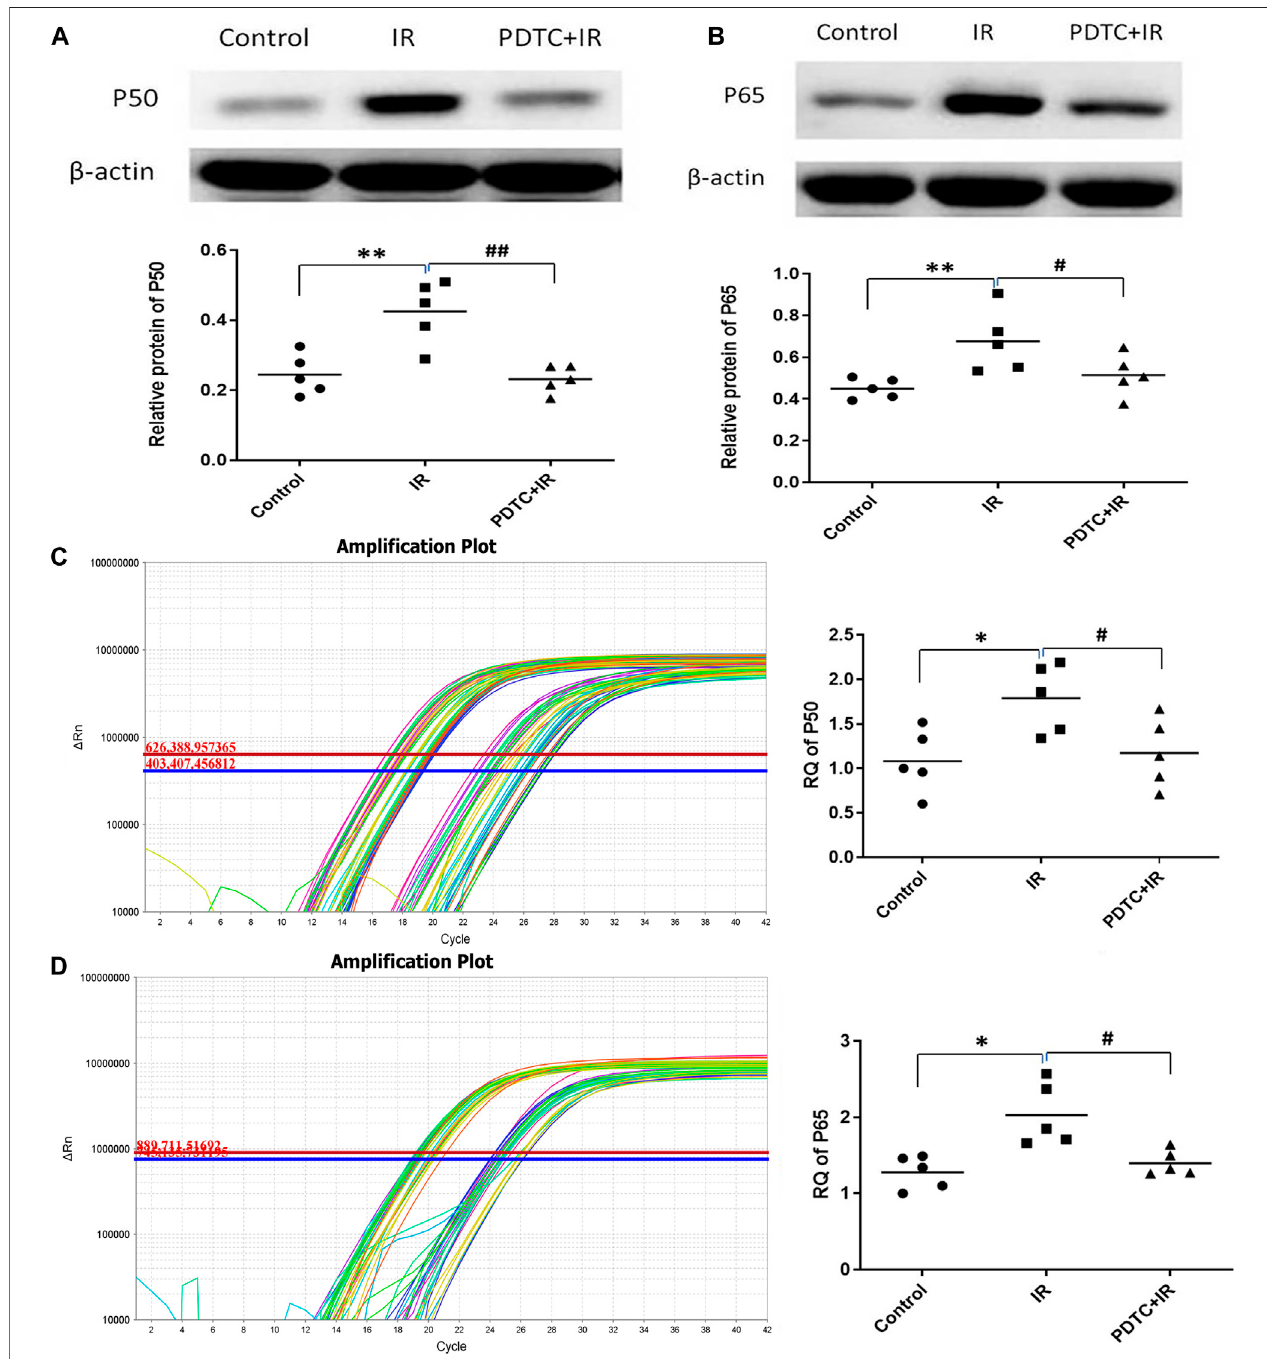
FIGURE5| EffectsofPDTCtreatmentontheexpressionofNF- κ BproteinandmRNAinthemyocardium. (A) and (B) showtheexpressionofP50andP65proteins revealedbyWesternblot. (C) and (D) showthemRNAlevelsofP50andP65analyzedbyqPCR( n =5).* p < 0.05forirradiationvs.controlgroup;** p < 0.01forirradiation vs. control group; # p < 0.05 for PDTC + irradiation vs. irradiation group; ## p < 0.05 for PDTC + irradiation vs. irradiation group.